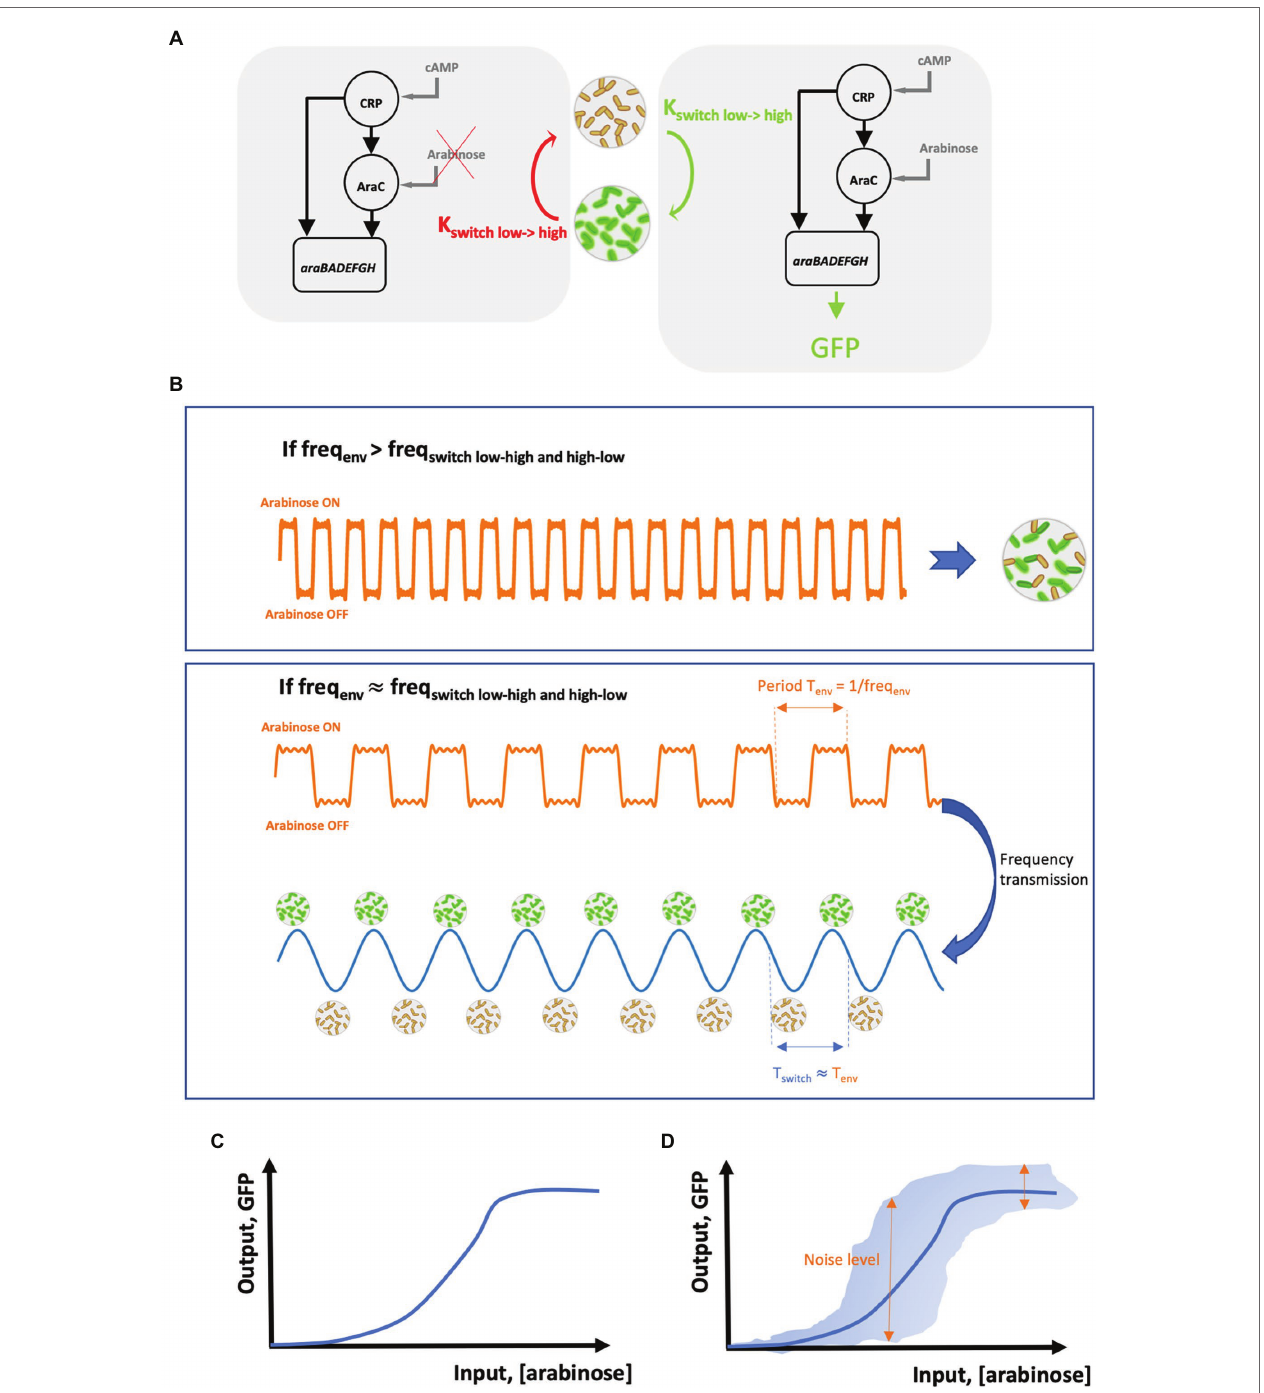
FIGURE 1 | (A) Scheme of the feedforward loop motif involved in the regulation of the arabinose operon. On the left, arabinose is not available and the AraC branch cannot be induced. Accordingly, cell switching does not take place and, eventually, previously induced cells are relaxed back to the uninduced (low) state at a rate K switch low->high . On the right, arabinose is available and the AraC branch, together with the cAMP-CRP branch, is activated leading to the induction of the genes araBADEFGH involved in arabinose metabolism. Under these conditions, cells from the low-state switch actively to the high state at a rate K switch high->low . (B) Proper coordination/synchronization of gene expression can be achieved based on periodic stimulations (or environmental fluctuations) made at a specific frequency freq env . If freq env is too high by comparison with the frequency for cell switching freq switch , then cells are not coordinated and exhibit strong variability in gene expression. However, when freq env is set close to freq switch , coordination in gene expression is possible leading to synchronized gene expression. (C) Typical shape of a Hill relationship between an input (here the concentration of arabinose in the medium) and its resulting output (here, detected based on the synthesis of GFP based on a P araBAD ::GFP transcriptional reporter). (D) Impact of biological noise (represented by double arrows) on the probability for delivering an output based on a given